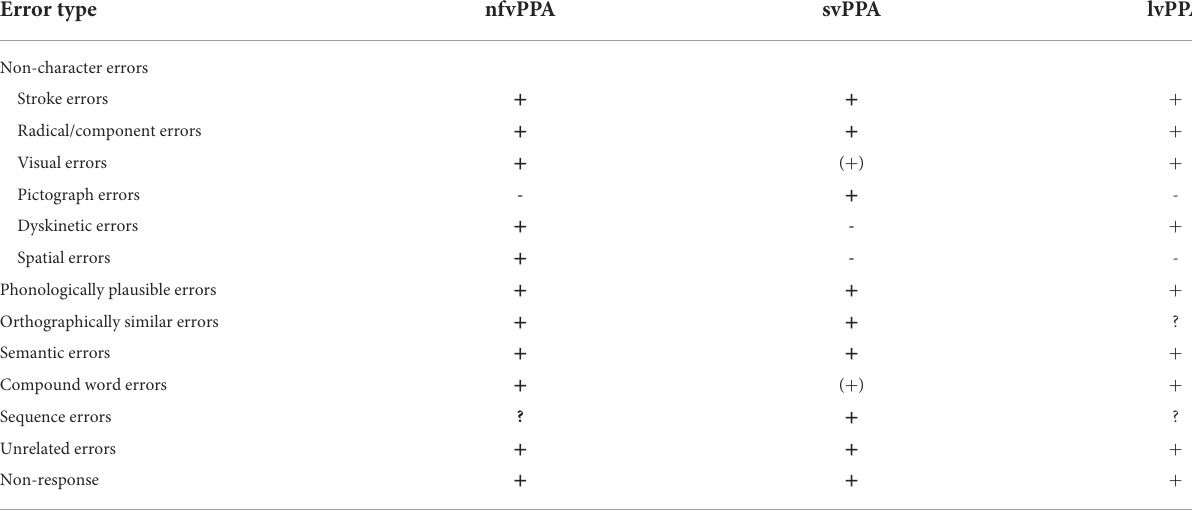
TABLE 4 Types of writing errors of patients with PPA